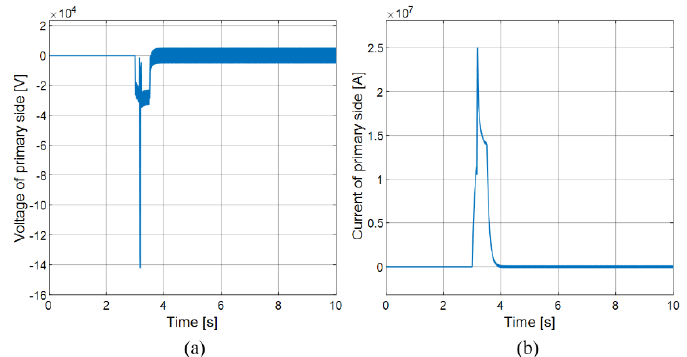
Figure 9. Current and voltage waveform of transformer: ( a ) voltage waveform; ( b ) current wave-